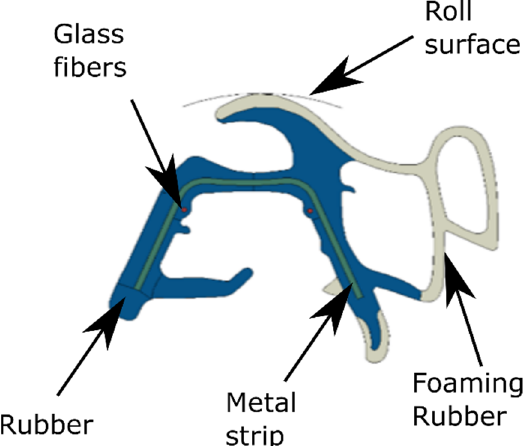
Figure 4. Parts of the automotive door seal.